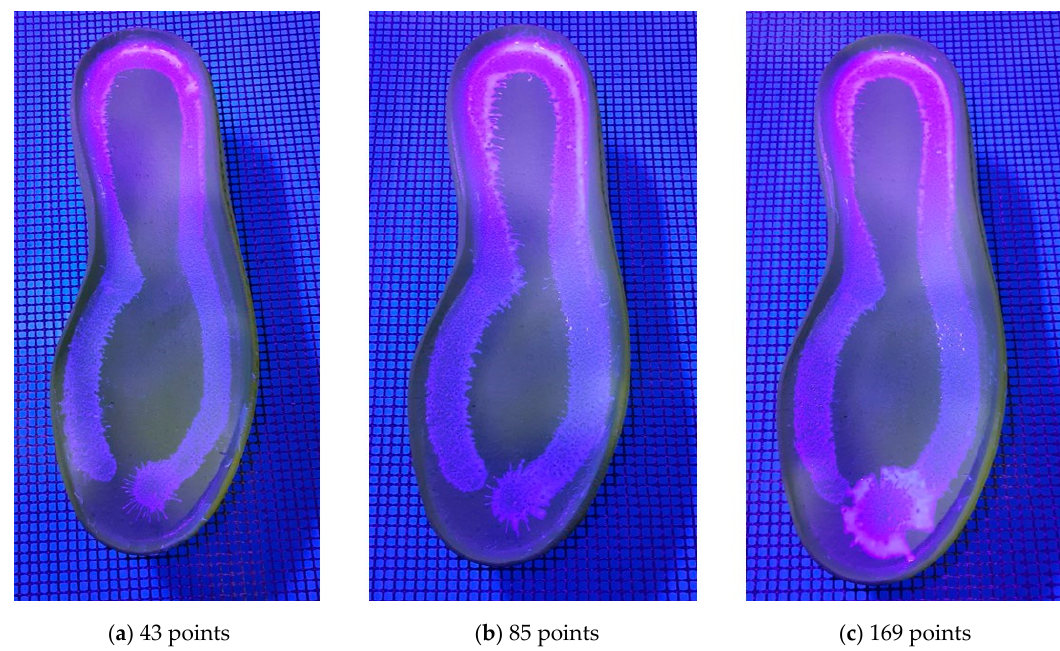
Figure 22. Test result for adhesive dispensing of shoe midsole depending on the number of the knots.